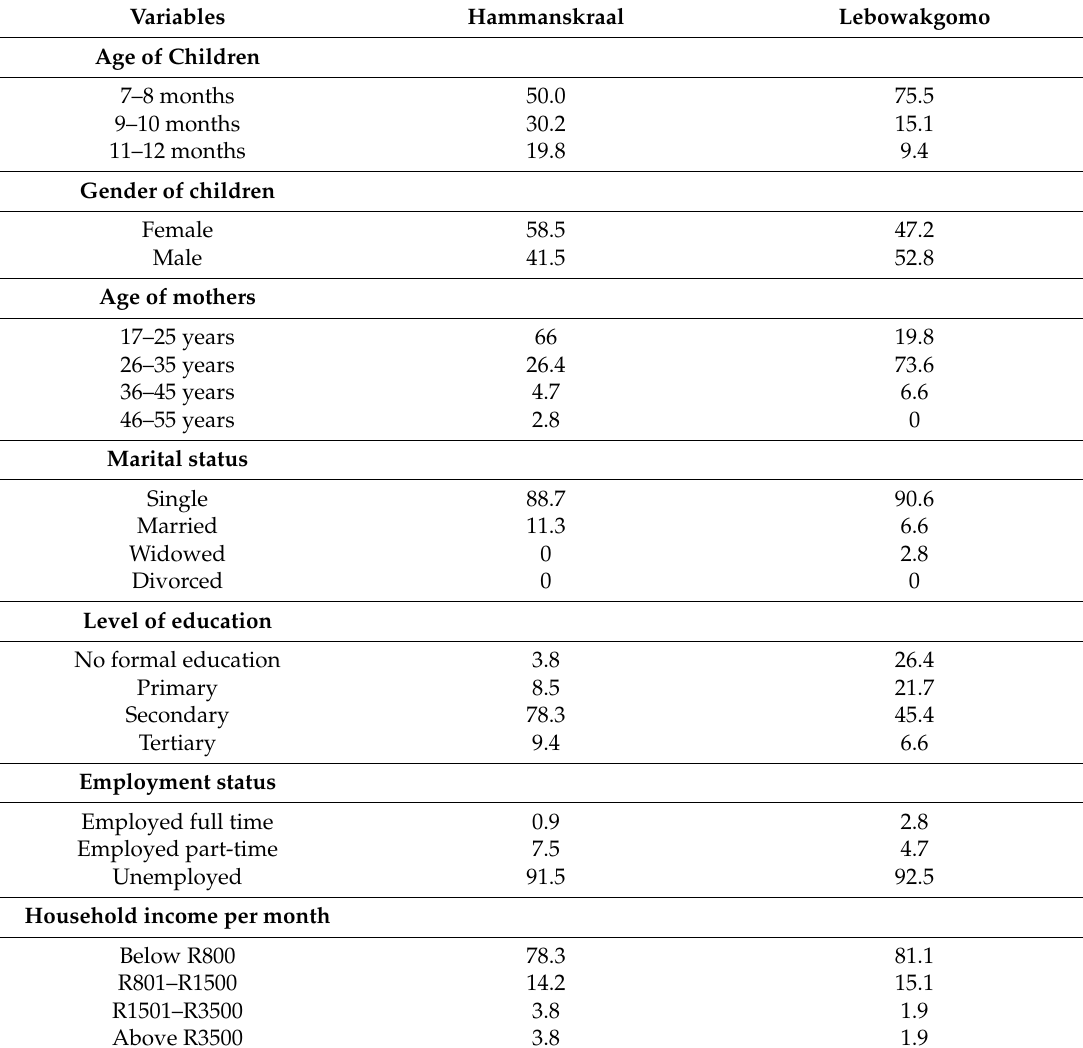
Table 1. Demographic profile of mothers and their children in Hammanskraal (Gauteng) and Lebowakgomo